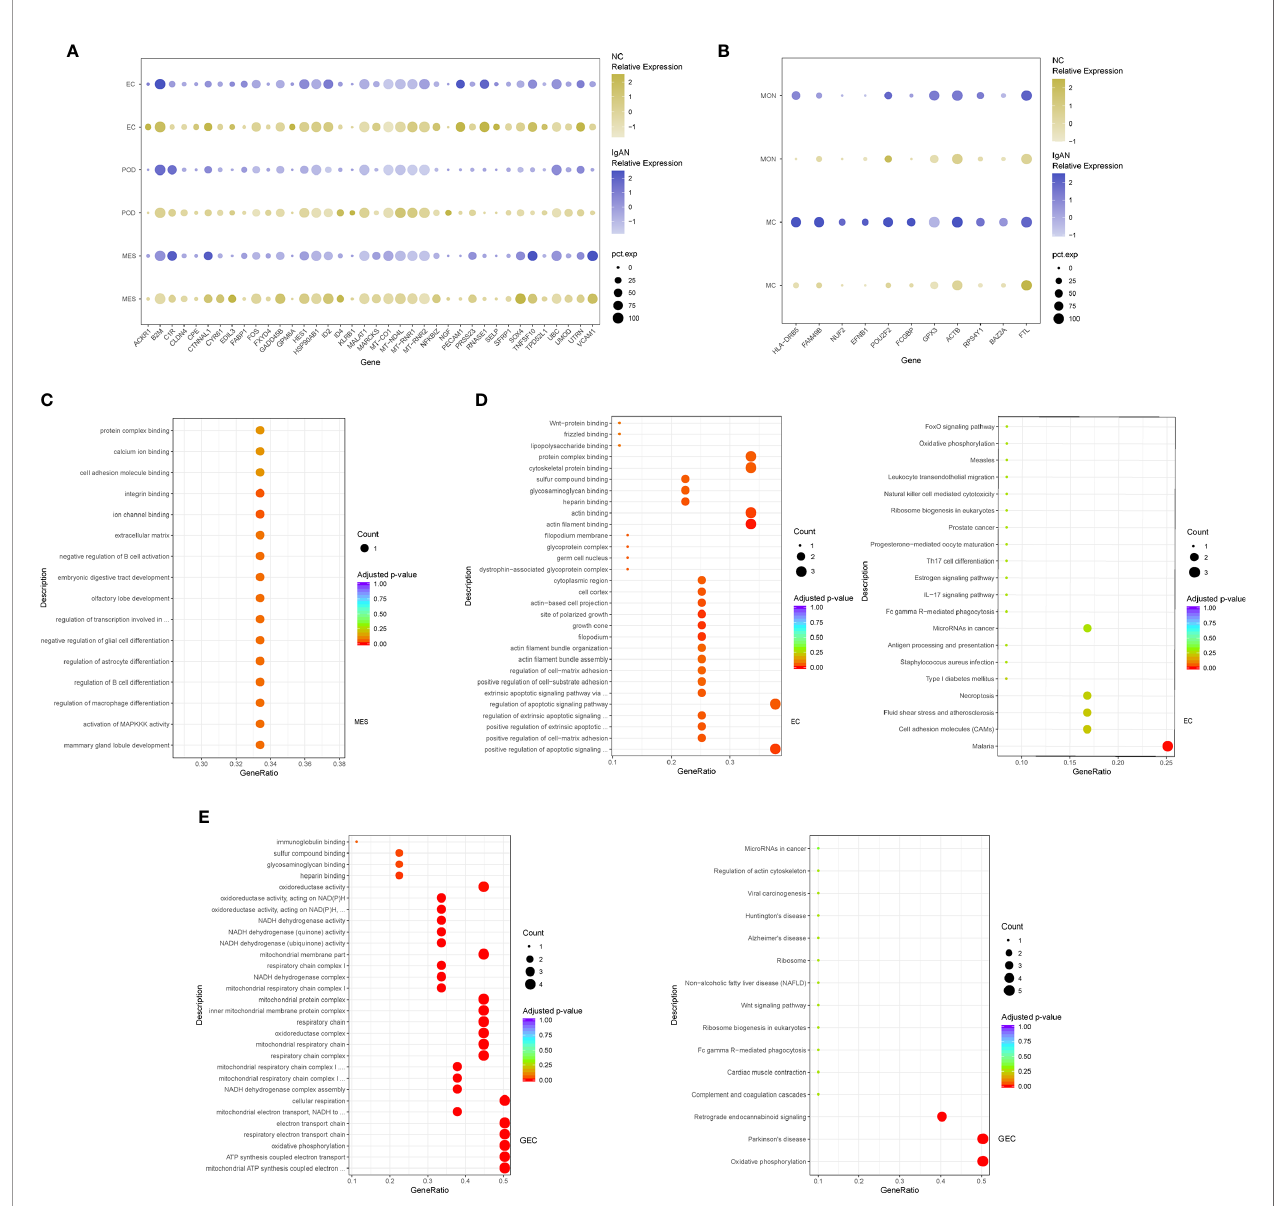
FIGURE 2 | DEGs and intercellular signaling in glomerulus and immune cells of IgAN and control subjects. (A) Representative DEGs in mesangial cells, endothelial cells and podocytes in kidney by comparing the transcriptional pro fi le of IgAN and control subjects. (B) Representative DEGs in monocytes and macrophages by comparing the transcriptional pro fi le of IgAN and control subjects. (C) GO enrichment analysis displayed that upregulated DEGs were involved in some biological processes in mesangial cells comparison with control subject. (D, E) GO and KEGG enrichment analysis revealed DEGs were mainly enriched in some biological processes and pathways in endothelial cells and glomerular endothelial cells respectively. Abbreviations were as follows: pct.exp, percentage of cells expressing gene; count, number of genes annotated to GO terms or KEGG